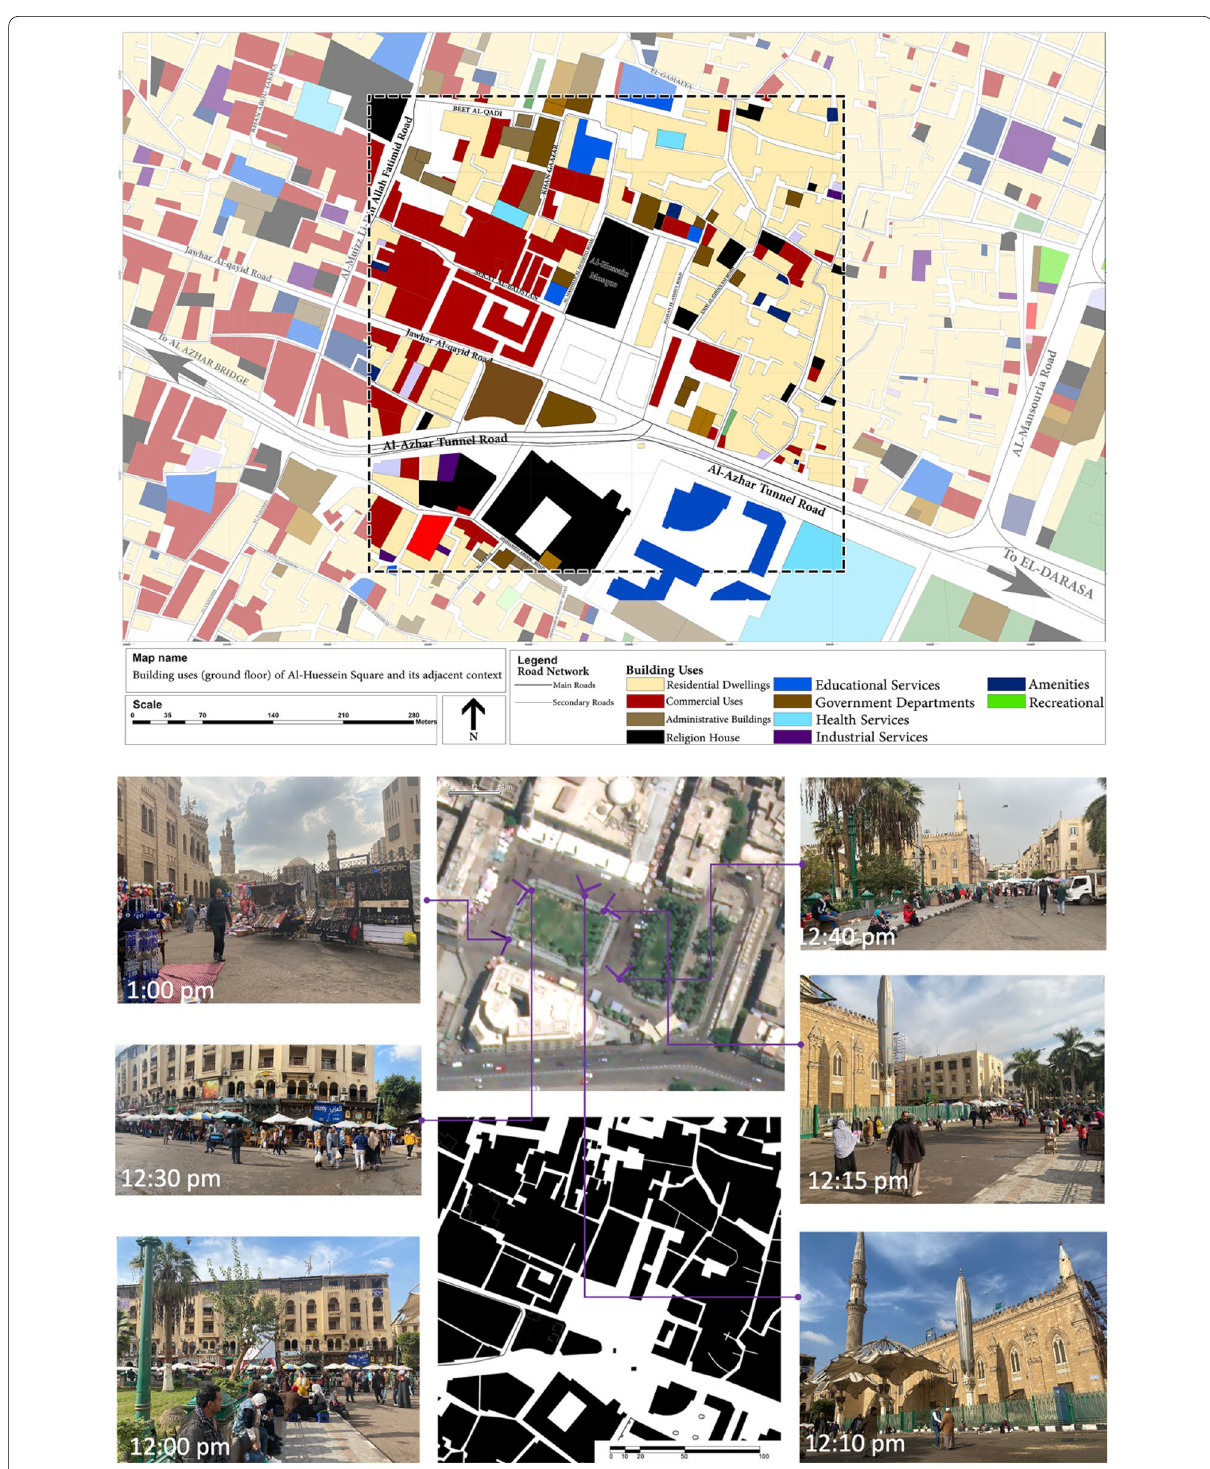
Fig. 4 The hyper-diversity of the uses and activities and the abstract of urban form (figure and